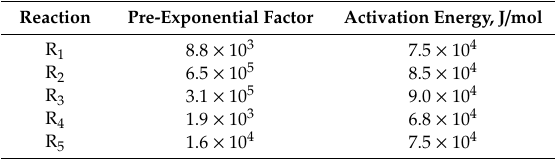
Table 2. Parameters for pyrolytic upgrading reaction kinetics [18].